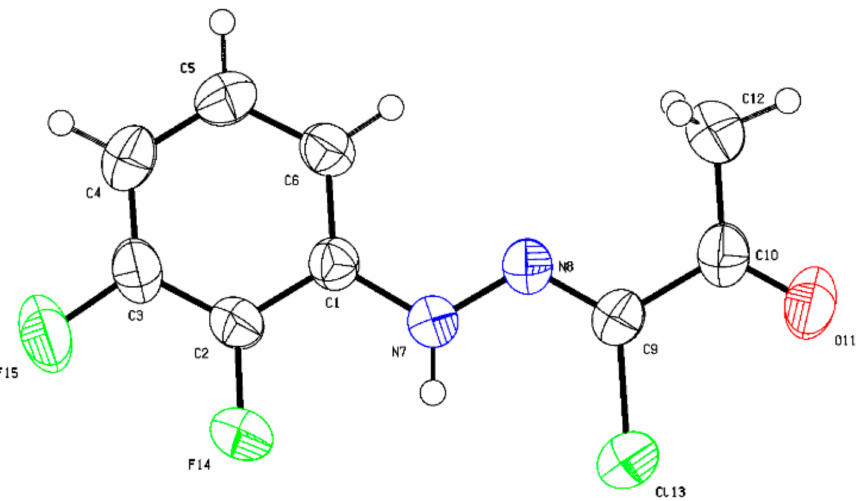
Figure 2. The crystal structure of (Z)-N -(2,3-difluorophenyl)-2-oxopropanehydrazonoyl chloride ( 29l ) (Deposi- tion Number 2179719 ). For bond distances (Å) and angles (deg), see Supplementary Materials Section.